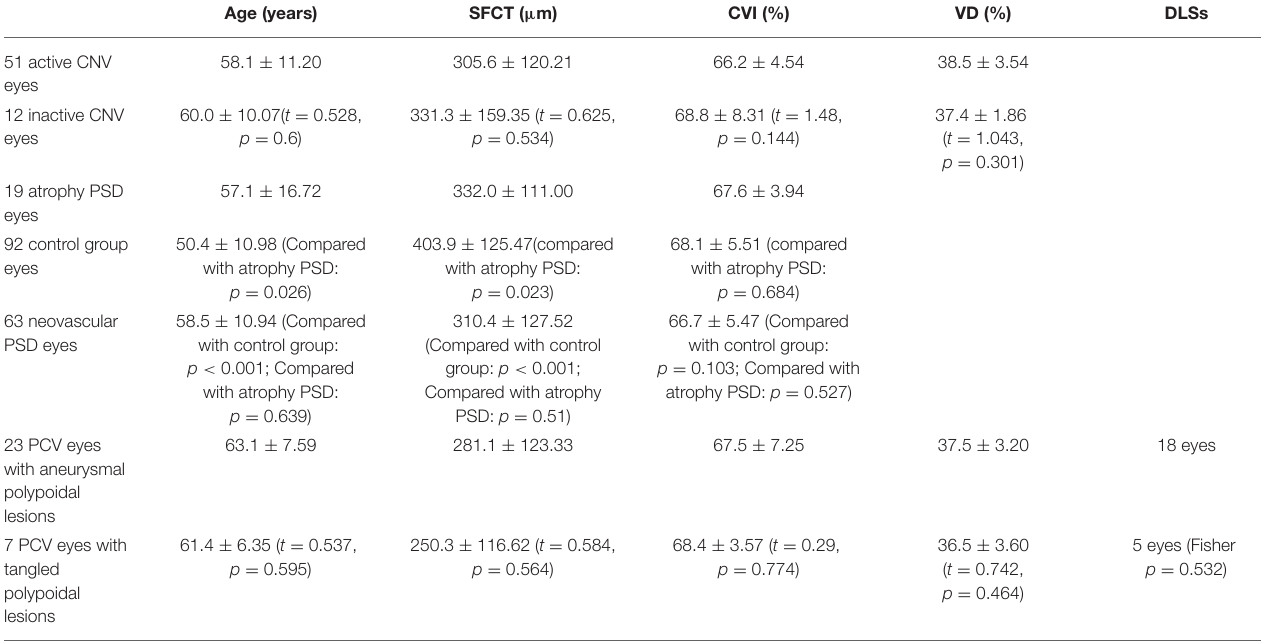
TABLE 2 | The comparison of influencing